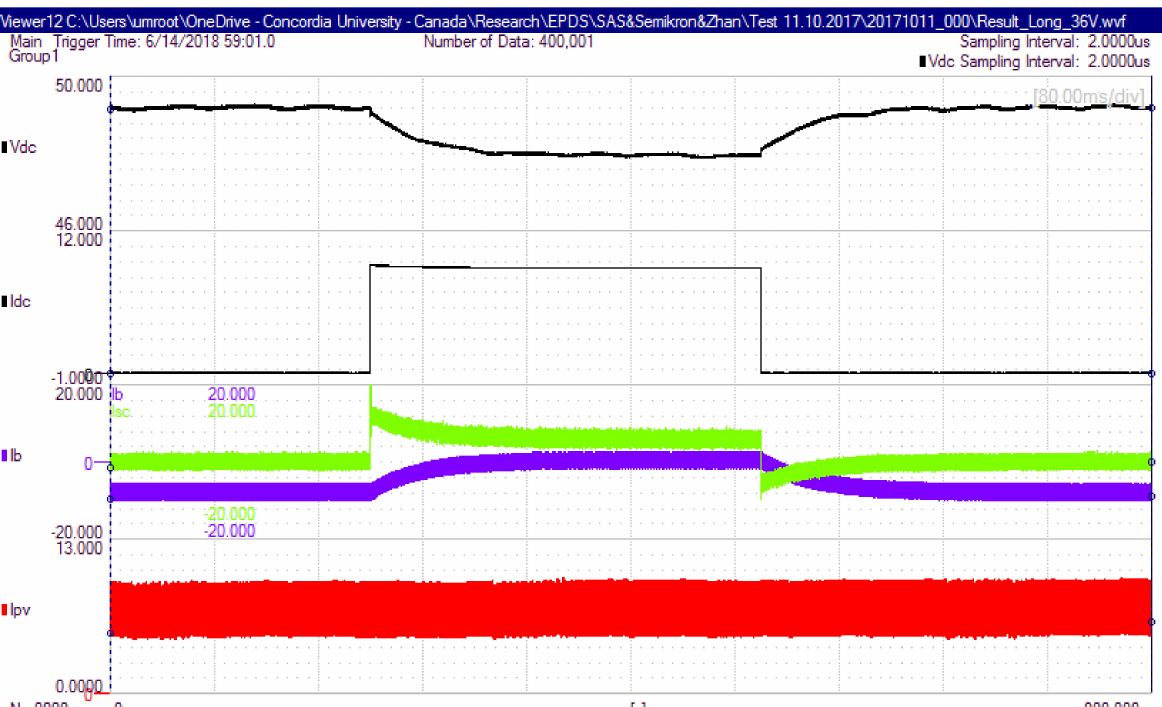
Figure 13. Experimental result for proposed dual scheme control at supercapacitor voltage V SC = 36 V when the load changed from no-load to 5.2 Ω and back to